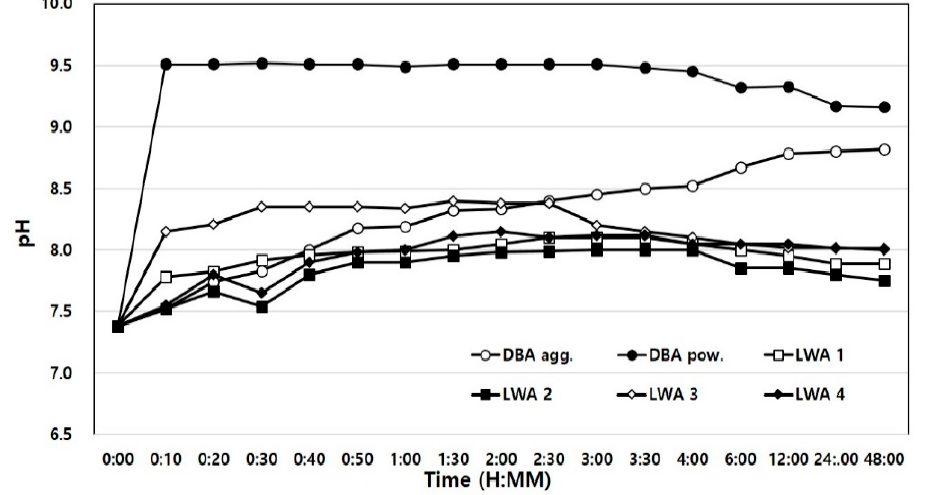
Figure 14. Time-dependent pH variance in tap water.